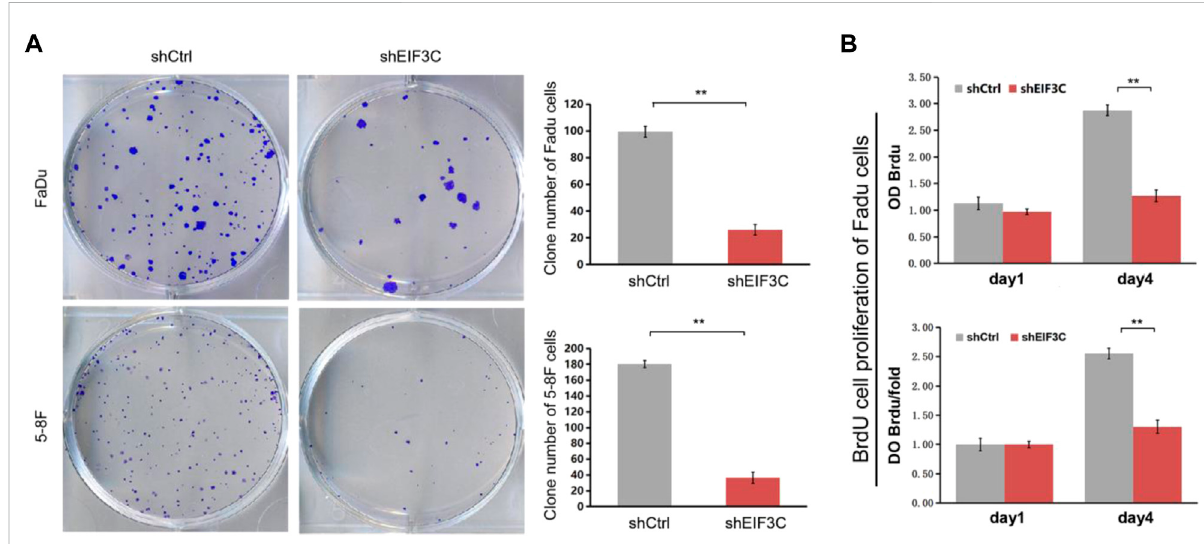
FIGURE 3 The L.v-shEIF3C inhibited the proliferation of FaDu and 5-8F cells in Colony formation assay and BrdU cell proliferation assay. (A) The images andthestatisticsexhibitedthatthenumberofclonecellsintheL.v-shEIF3CgroupwaslessthanthatintheL.v-shCtrlgroup. (B) Themagnitudeofthe absorbance for the developed color in the L.v-shCtrl group was greater than that in the L.v-shEIF3C group detected at 450 nm. The data is the means ± SDs of three independent experiments. The differences were statistically signi fi cant. ** p <